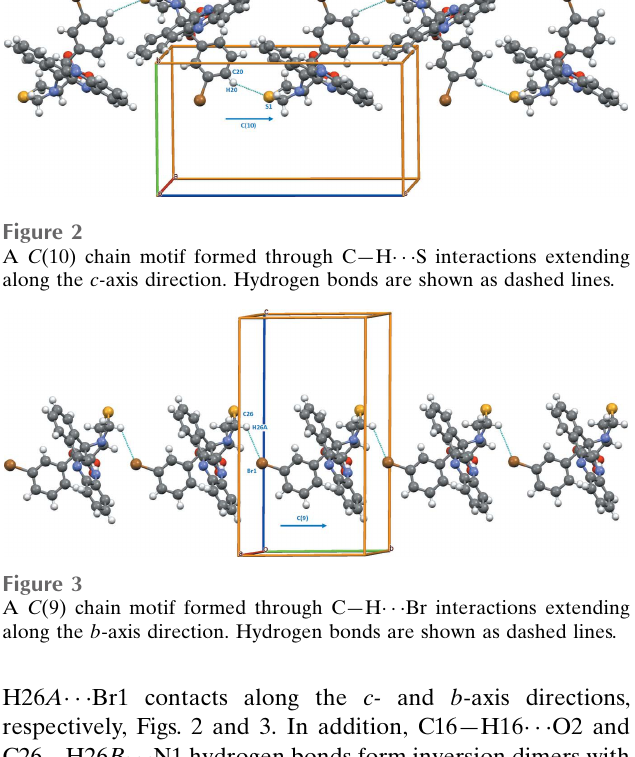
Fig. 4. These contacts combine to stack molecules along the b- axis direction, Fig. 5.